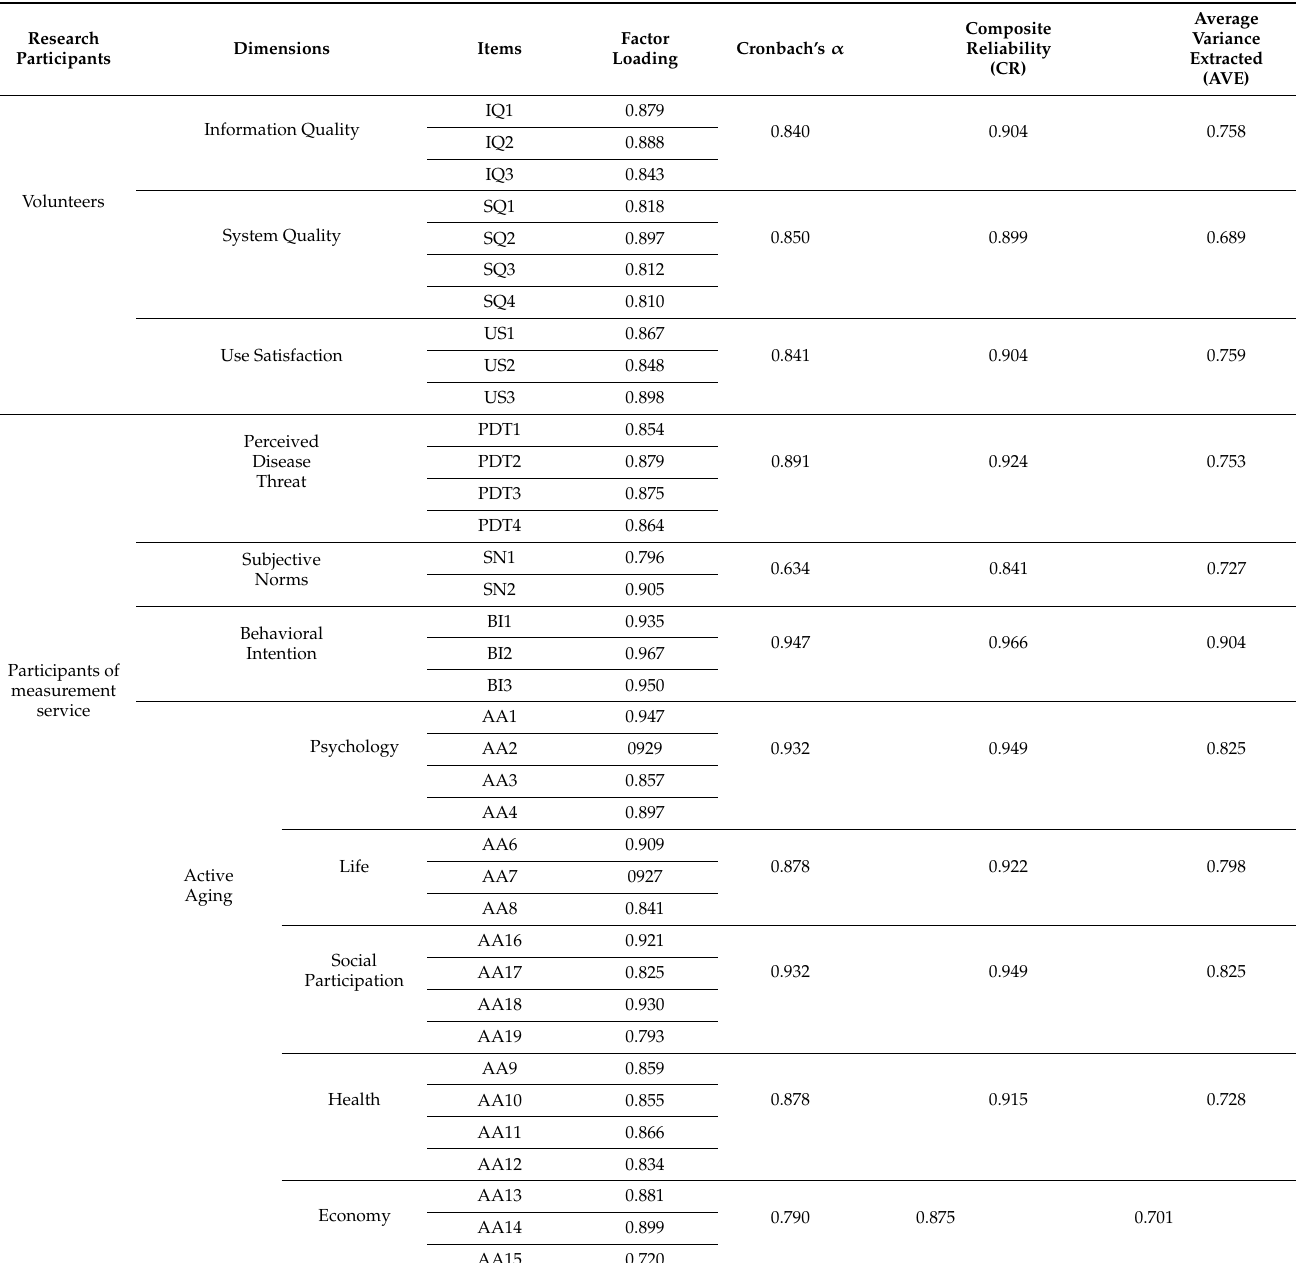
Table 3. Reliability and validity